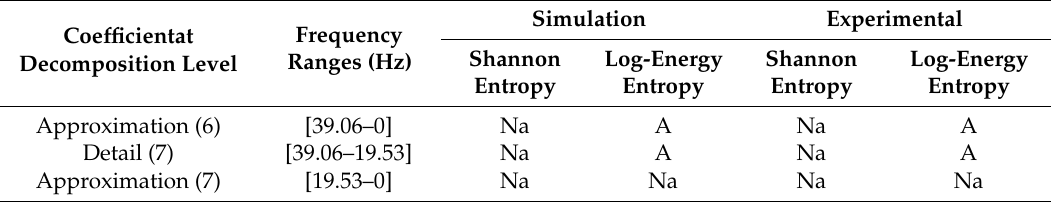
Table 6. Conclusion for feature validation in the simulation and